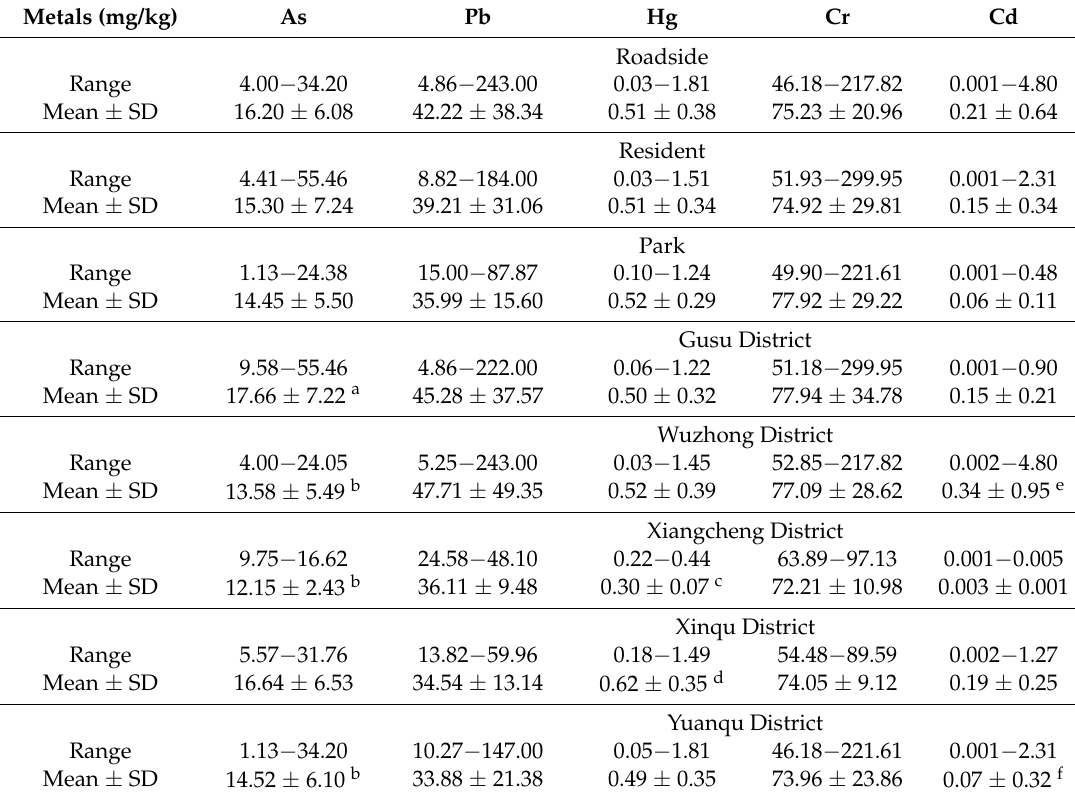
Table 3. Distribution characteristics of soil metals in different land use types and different